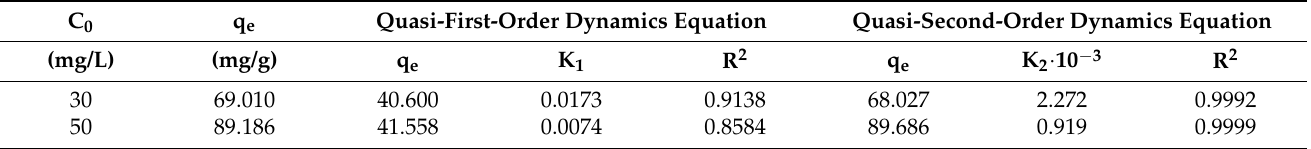
Table 2. Parameters of kinetic models for As(V) onto Fe 3 O 4 @ZIF-8. C 0 q e